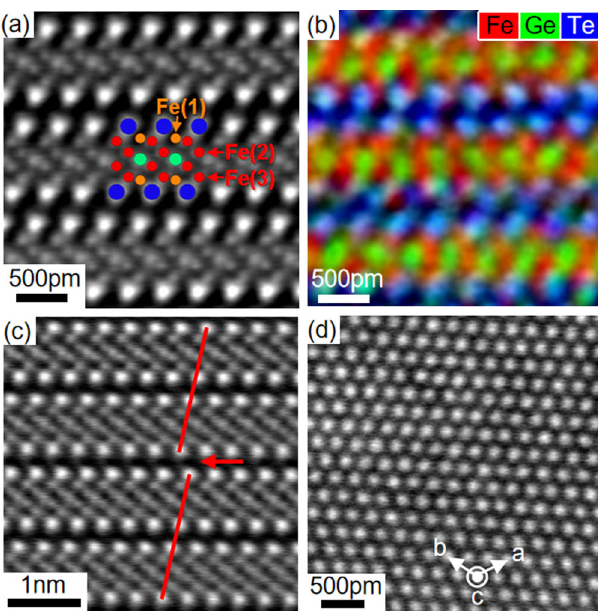
Fig. 1 High resolution analyses of the crystal structure of Fe 5 GeTe 2 . a High resolution high angle annular dark- fi eld detector (HAADF) scanning transmission electron microscopy (STEM) image of the structure with the c-axis along the vertical direction in the image plane. b Color-coded energy dispersive X-ray (EDX) composition map showing the distribution of iron, germanium and tellurium. A schematic model of the atomic structure is overlaid on image (a) with the same color code as in panel b . c HAADF STEM image showing a stacking fault as indicated by red lines and an arrow. d HAADF STEM image of the structure with the c-axis perpendicular to the image (HAADF) scanning transmission electron microscopy (STEM) image of the quenched single-crystal Fe 5 GeTe 2 used in the pre- sent work. Figure 1(b) is a color-coded composition map obtained using energy dispersive X-ray (EDX) spectroscopy, which shows the periodic distribution of iron, germanium and tellurium. 2D layers consist of a sandwich of two planes of Te (brightest columns) with Ge and Fe planes located in-between. The layers are stacked along the c-axis and are approximately 1 nm thick including the vdW gap (dark area between two